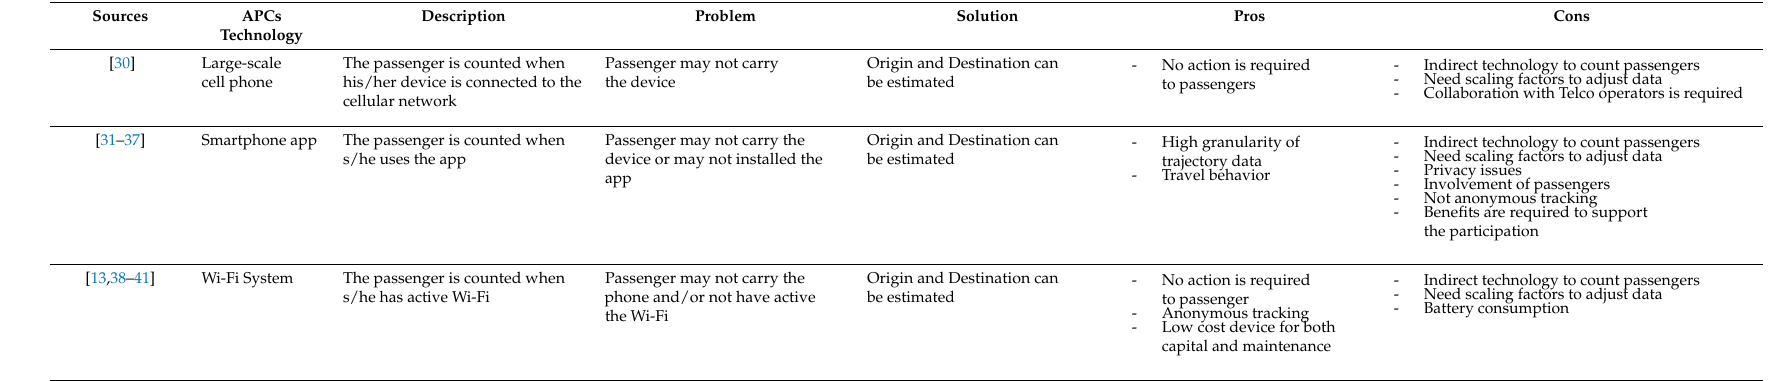
Table 2. Studies on emerging APC technologies (the list of references is representative, but not